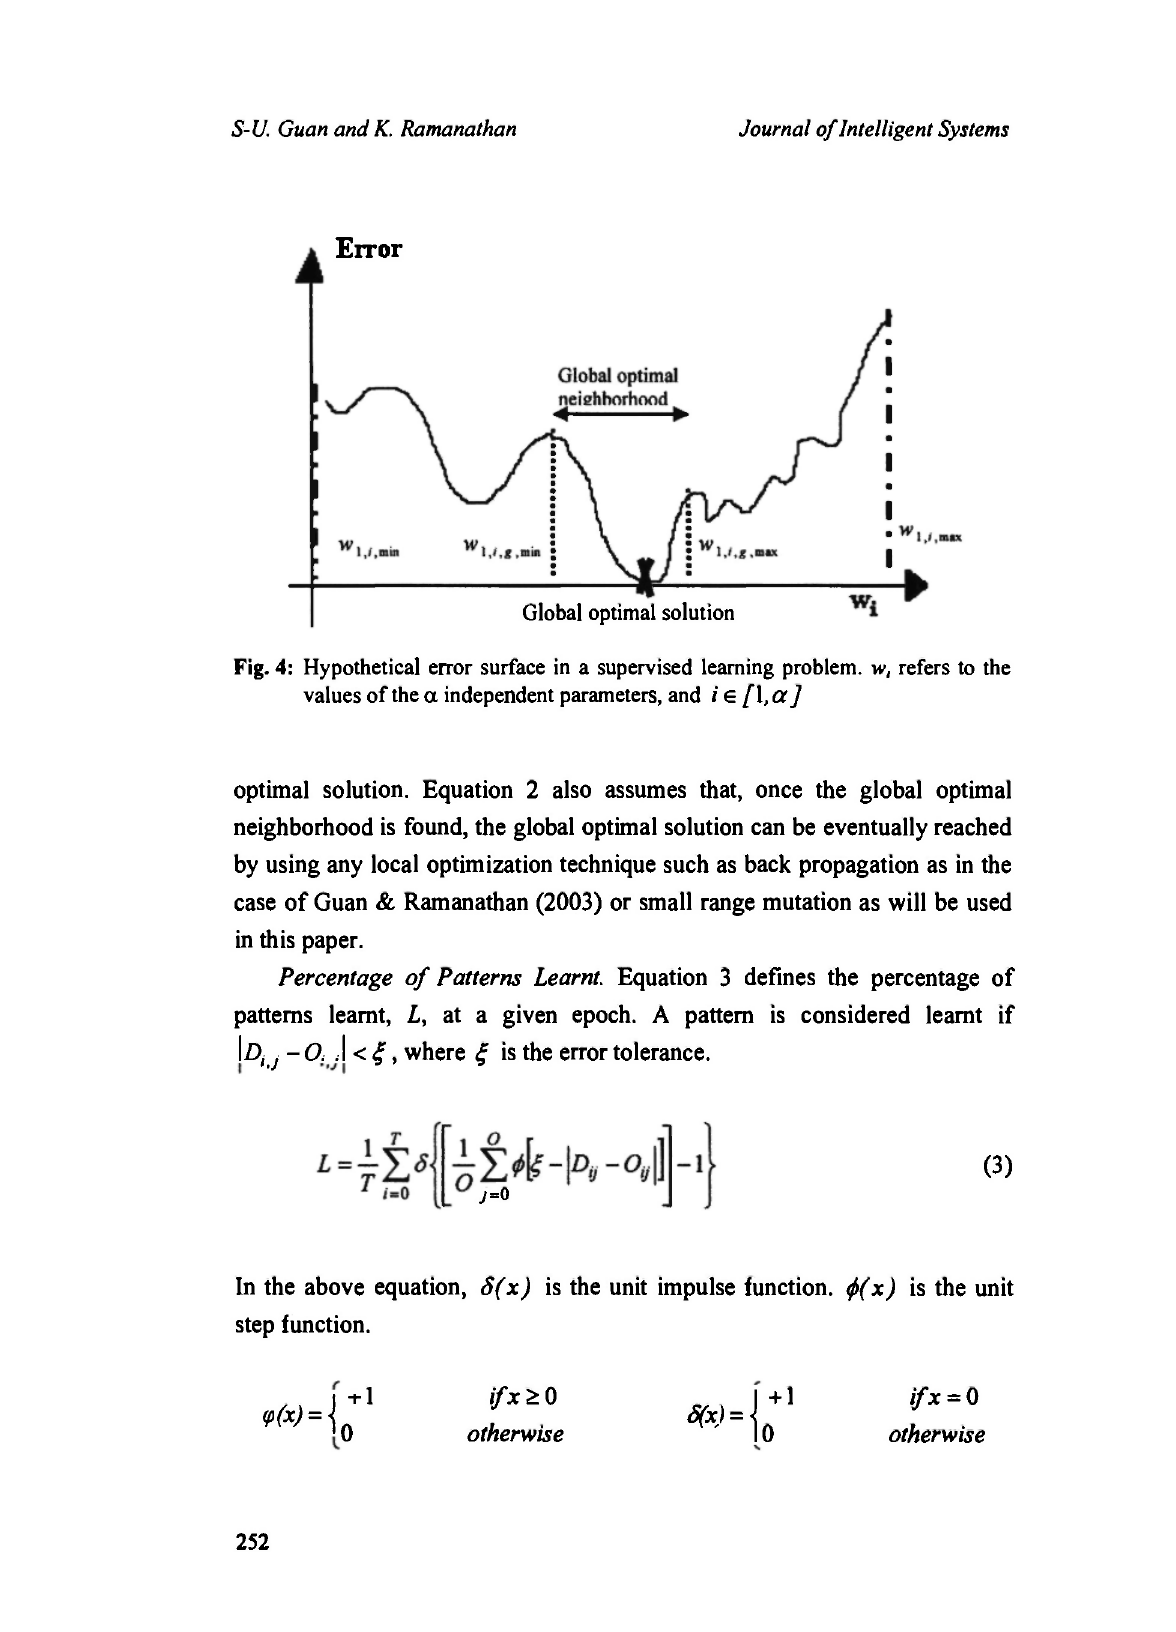
In the above equation, δ(χ) is the unit impulse function. φ(χ) is the unit step